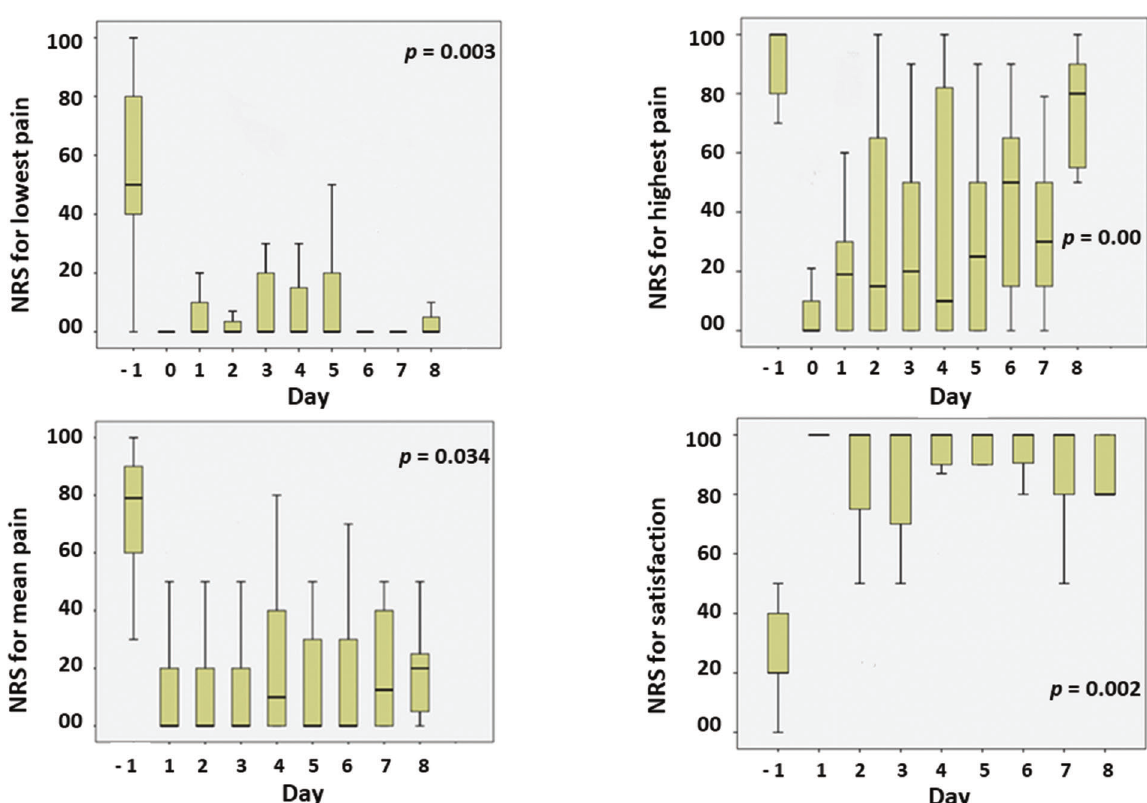
Figure 2 - Daily evolution for lowest pain scores, highest pain scores, mean pain scores and satisfaction with analgesic treatment. NRS: numerical rating scale; Day -1: before CPNB; Day 0: immediate post CPNB initiation. Friedman test.